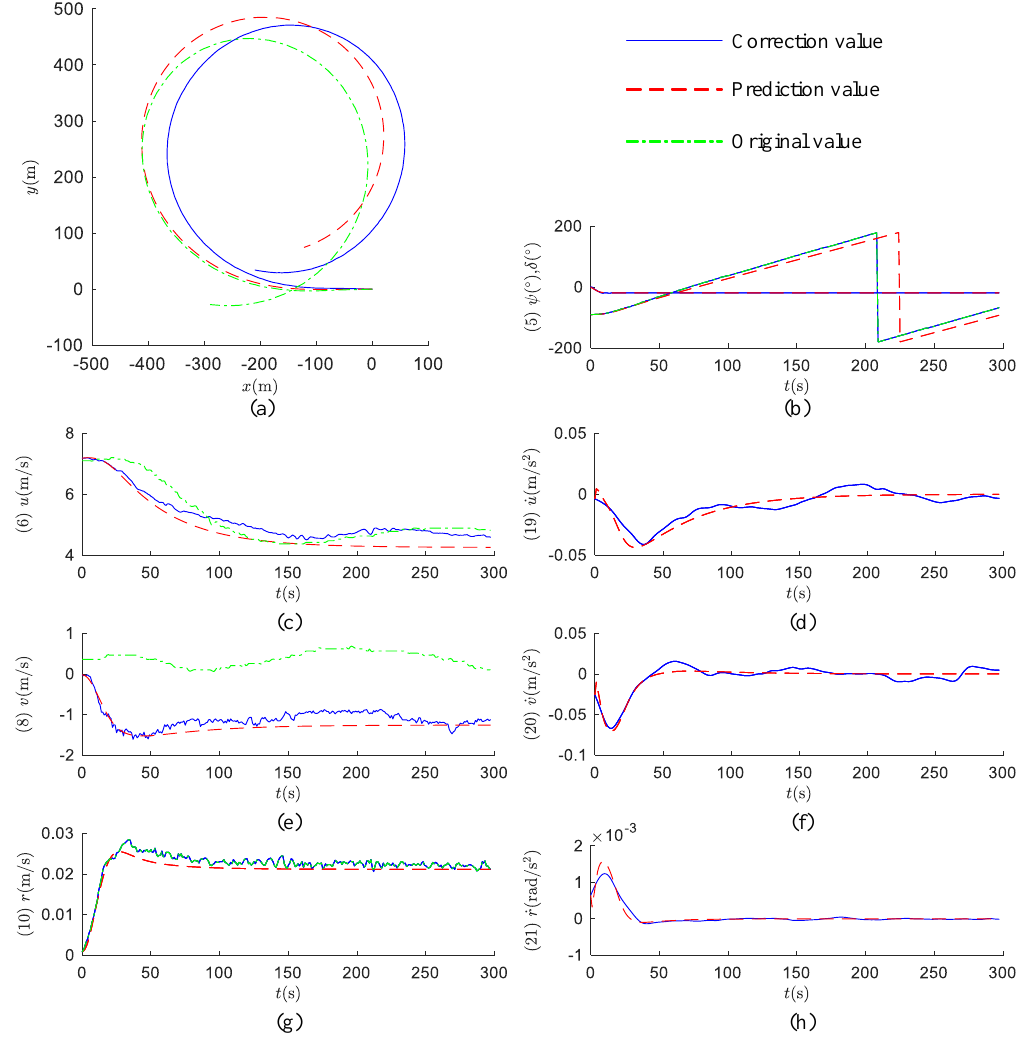
Figure 11. Prediction for +20° turning circle test. ( a ) Ship track; ( b ) ship heading angle and rudder angle; ( c ) surge velocity; ( d ) surge acceleration; ( e ) sway velocity; ( f ) sway acceleration; ( g ) yaw velocity; ( h ) yaw acceleration.